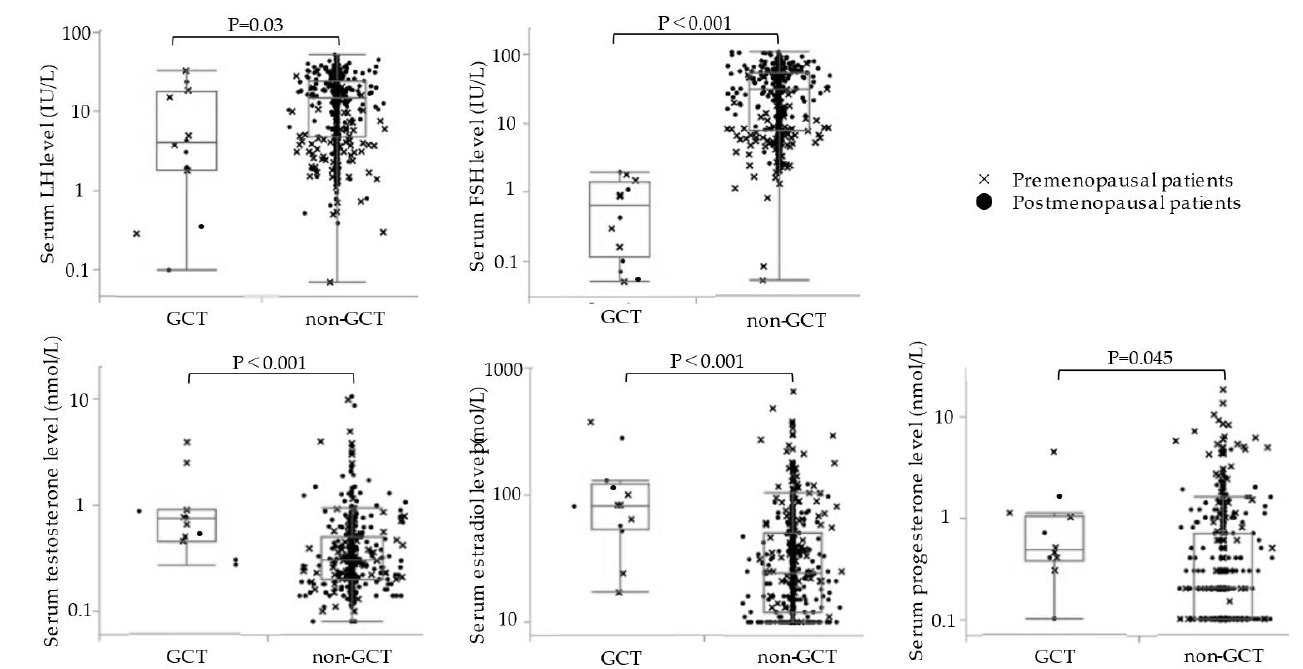
Figure 2. Univariate analyses of serum hormone levels in the GCT ( n = 13) and non-GCT groups ( n = 458). Differences between the GCT and non-GCT groups were analyzed for unpaired data using the Mann – Whitney U test. GCT, granulosa cell tumor; FSH, follicle-stimulating hormone; LH, luteinizing hormone. Table 2. Multivariate logistic regression analysis evaluating the associations between serum hormone levels and granulosa cell tumors with receiver operating characteristic curve analysis for granulosa cell tumor.